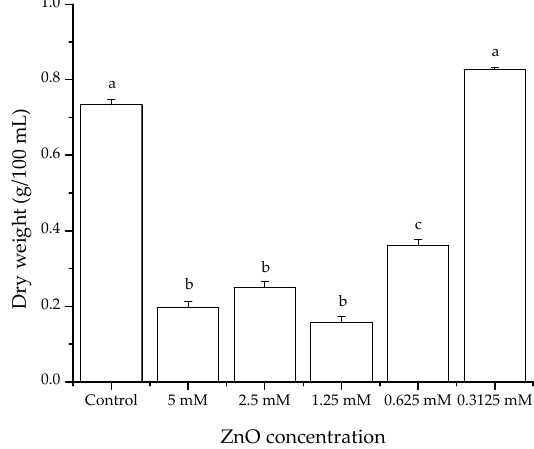
Figure 7. Effect of nanostructured ZnO on mycelial growth of Aspergillus flavus in culture media. Mean values ± standard error of three independent experiments. Bars not sharing a common superscript differ significantly (Dunnett < 0.05).